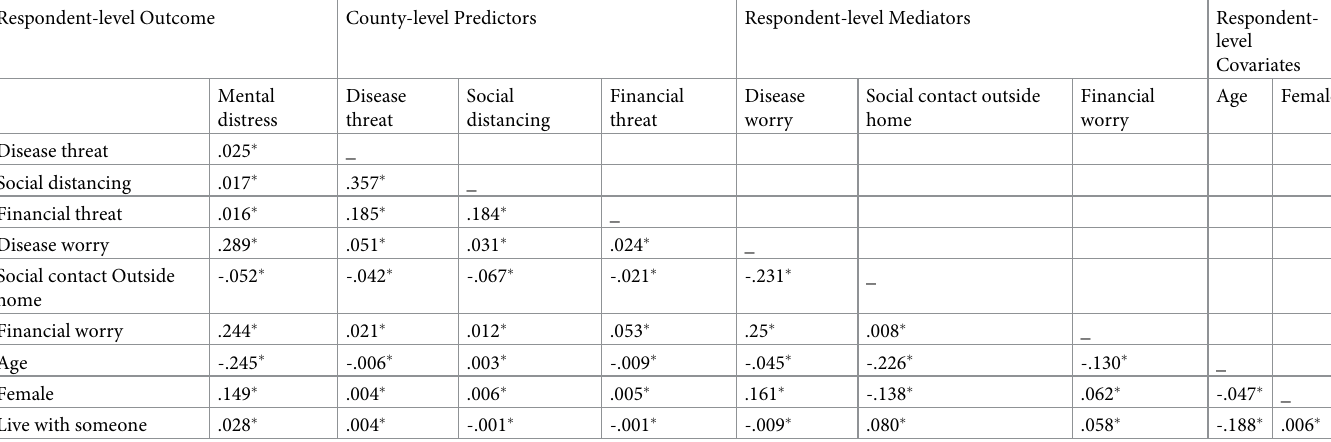
Women, younger respondents, and respondents living alone reported greater mental distress compared to men, older respondents and those living with others respectively. The associa- tions of mental distress with these demographic characteristics are all consistent with prior Table 3. Correlation among variables used in the analysis ( � p <